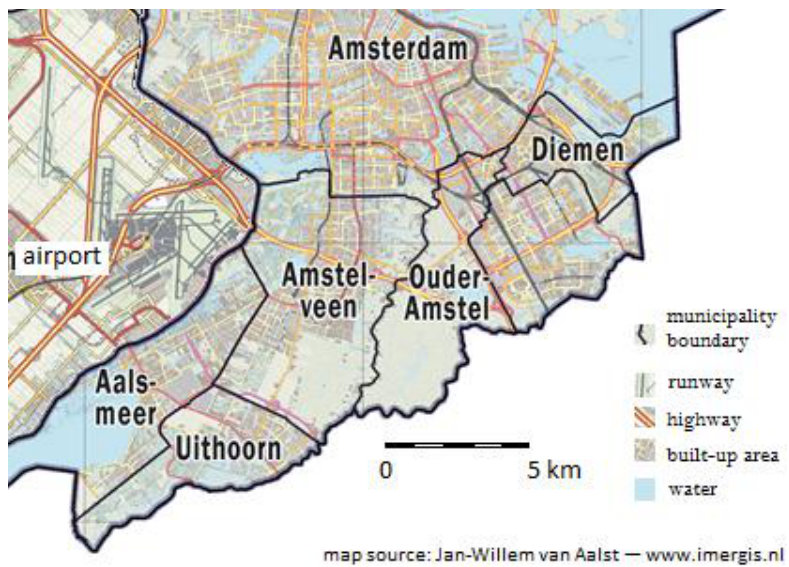
Figure 1. Study area with five surveyed municipalities, airport (grey area with runways) at west and Amsterdam at